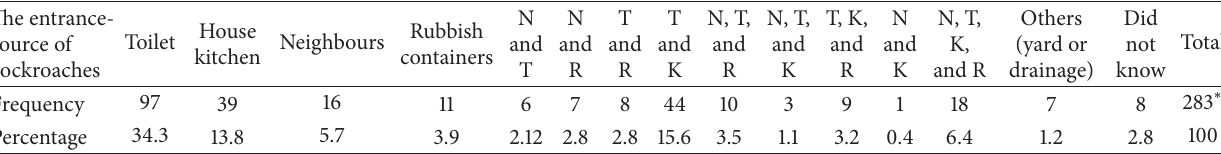
Table 6: The entrance-source of cockroaches according to standpoint of occupants for 283 surveyed units of dormitories. The entrance- House Toilet source of kitchen cockroaches